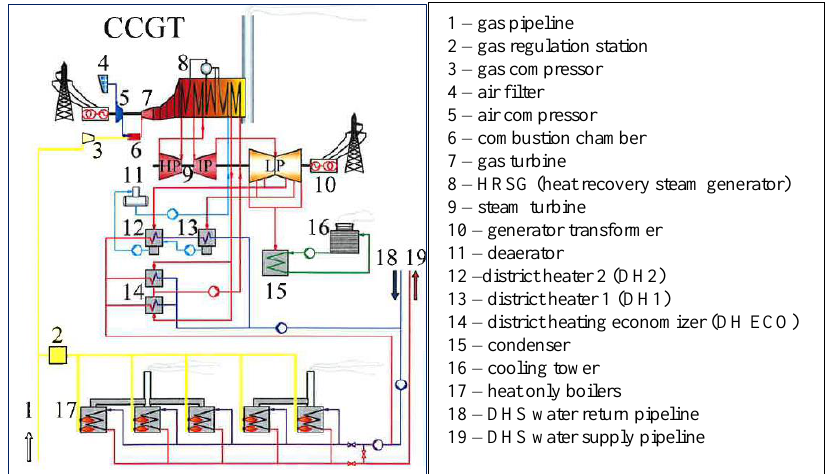
Fig. 1. Riga CHP-2 CCGT-1